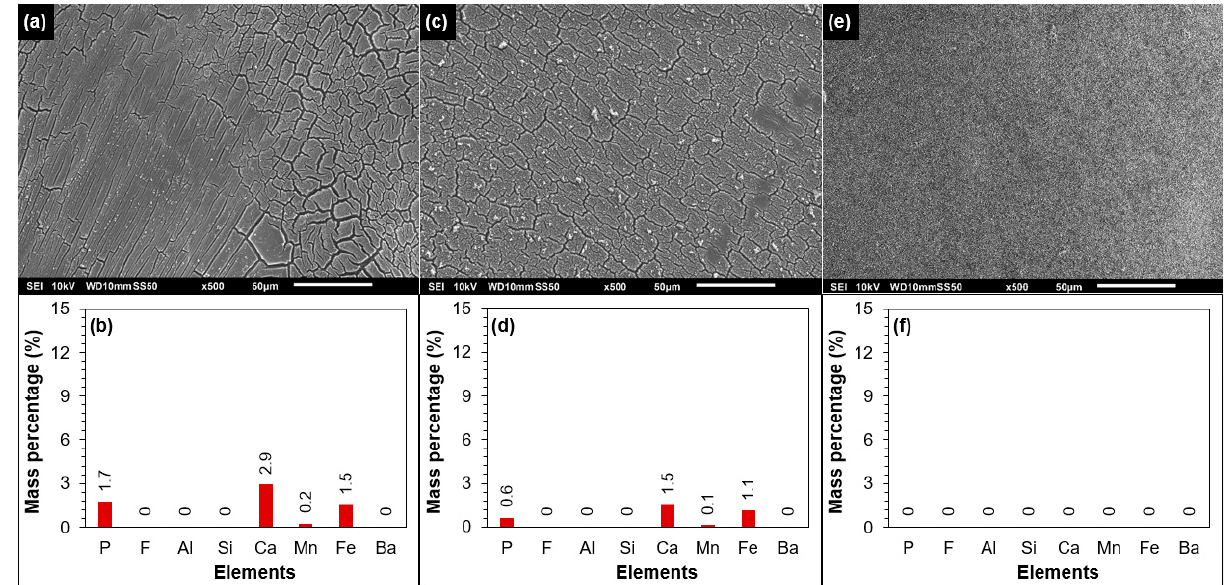
Figure 7. ( a ) SEM and ( b ) EDX analyses of the fouled tail element of the third stage. ( c ) SEM and ( d ) EDX analyses of the tail element of the third stage cleaned with 0.05 M NaOH solution. ( e ) SEM and ( f ) EDX analyses of the tail element of the third stage cleaned with 0.05 M HCl solution.